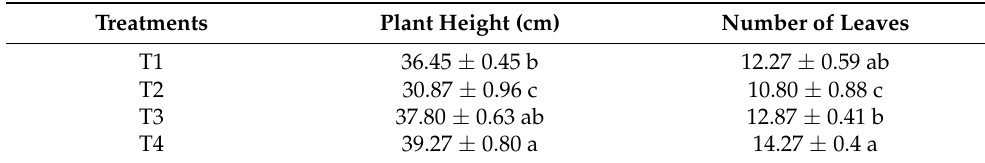
Table 1. The effect of B. bassiana on the growth of tomato plants (n = 60) that were drenched with FOL conidial